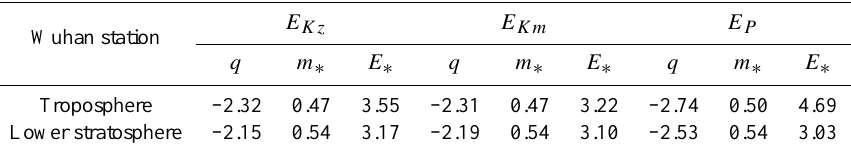
Table 2. Parameters of vertical wave number spectra for GWs in the troposphere and lower stratosphere over Wuhan station. E Kz , E Km and E P represent the zonal kinetic, meridional kinetic and potential energy densities, respectively. q represents the slope of the vertical wavenumber spectrum in the large wave number regions. m ∗ (in (Cycle/km) and E ∗ (in m 2 s 2 /(Cycle/km)) denote the characteristic vertical wave number and the corresponding spectral intensity.